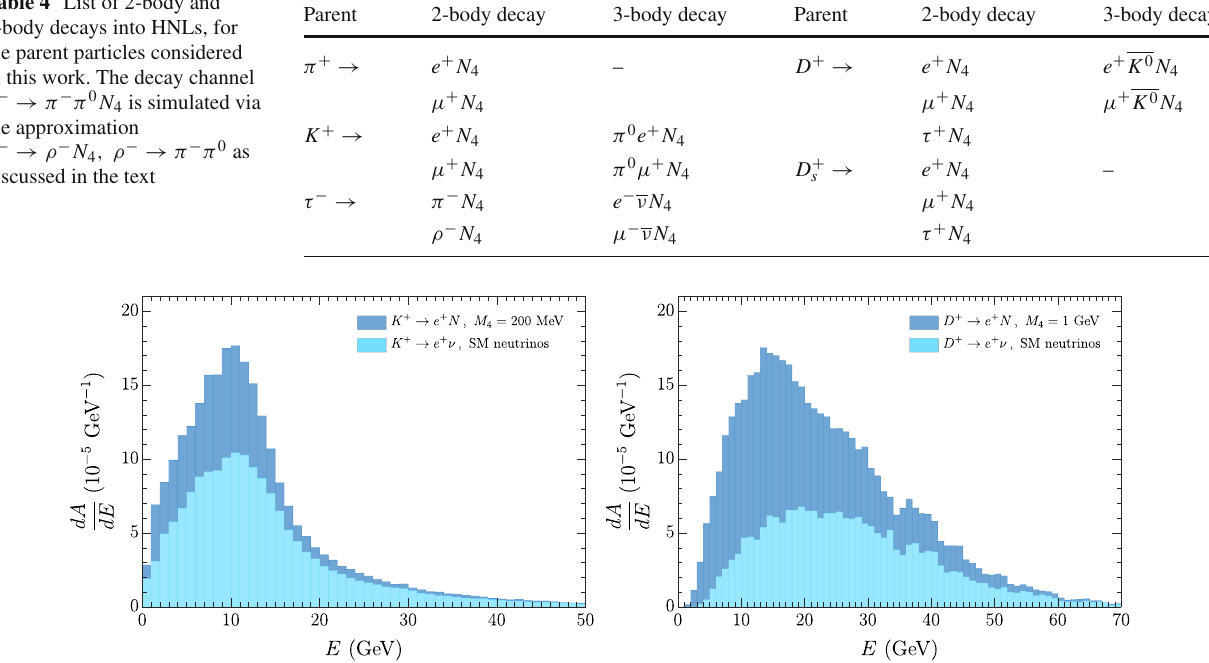
1 GeV, produced from D + → e + N 4 decays (right panel). In both pan- els, the light blue histogram shows the detector acceptance when the neutrino mass is set to zero